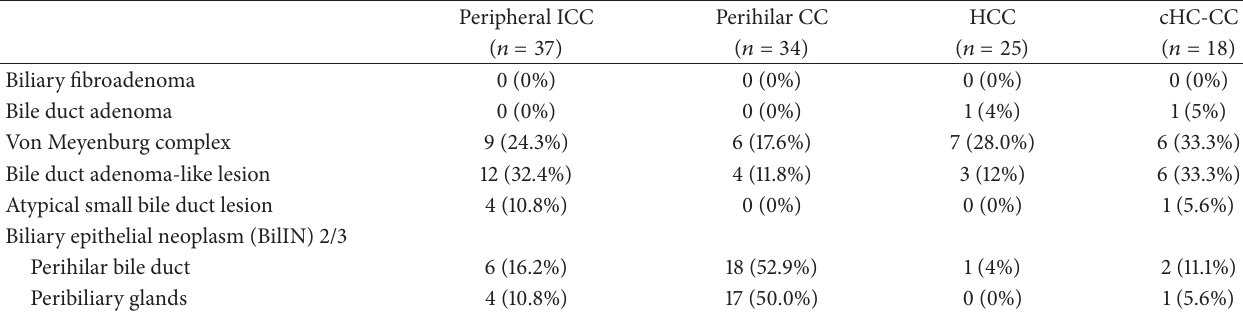
Table 2: Occurrence of biliary epithelial lesions related to cholangiocarcinoma.